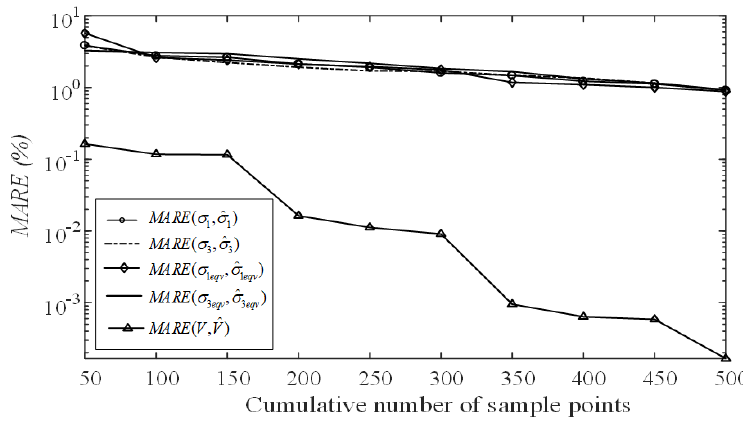
Figure 4. The variation of the maximum absolute relative errors (MARE s) between σ 1 and ˆ σ 1 , σ 3 and ˆ σ 3 , σ 1 eqv and ˆ σ 1 eqv , σ 3 eqv and ˆ σ 3 eqv , and V and ˆ V with the number of sample points increasing.